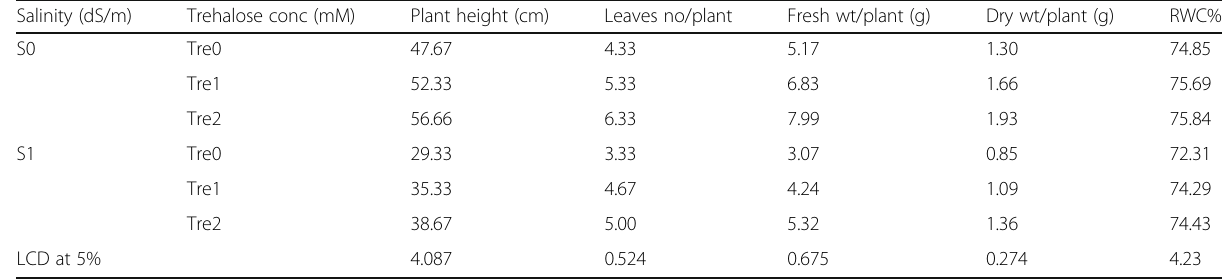
Table 2 Effect of trehalose at 0 mM (Tre 0), 10 mM (Tre 1), and 50 mM (Tre 2) on growth parameters of wheat plants irrigated with tap water (S0) or diluted sea water at 6.25 dS/m (S1). Results are means of two successive seasons Salinity